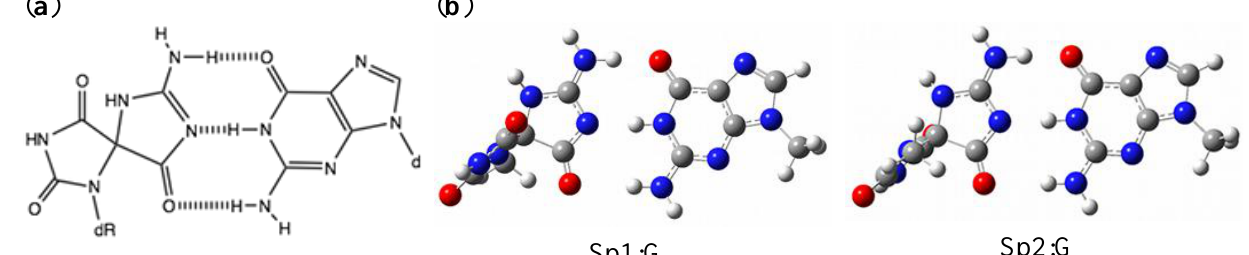
Figure 3. The Sp:G base pairs. ( a ) The proposed Sp:G base pair. ( b ) The geometries of Sp1:G and Sp2:G optimized by ab initio calculation. The stabilization energies are shown in Table